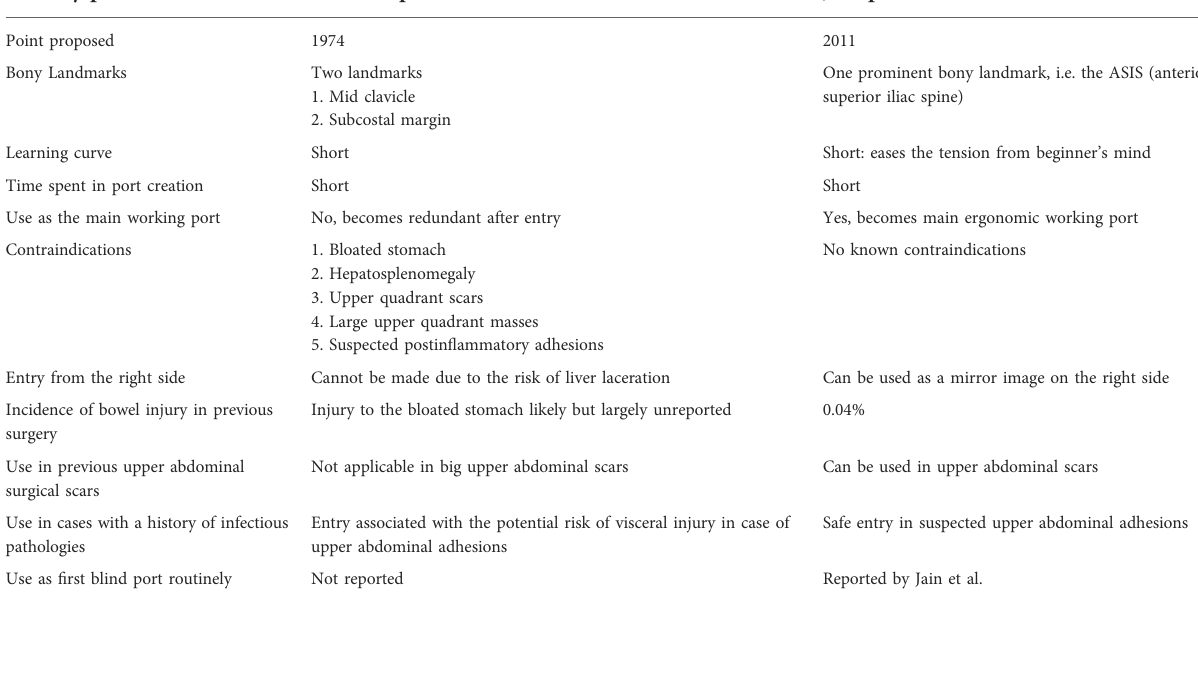
TABLE 1 Differences between Jain point and Palmer ’ s